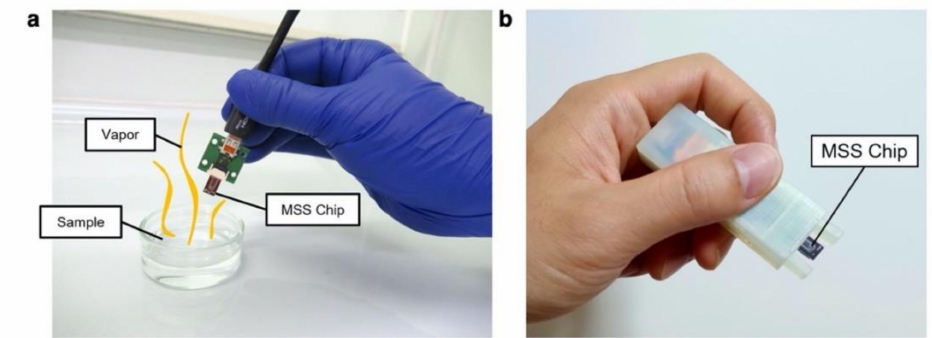
Figure 19. Free-hand measurement setup. Note that this approach requires only a sensor array and a readout device. ( a ) Picture of the free-hand measurement setup. ( b ) Picture of a wireless free-hand measurement device. Reprinted from [173,174], the author licensed under CC-BY